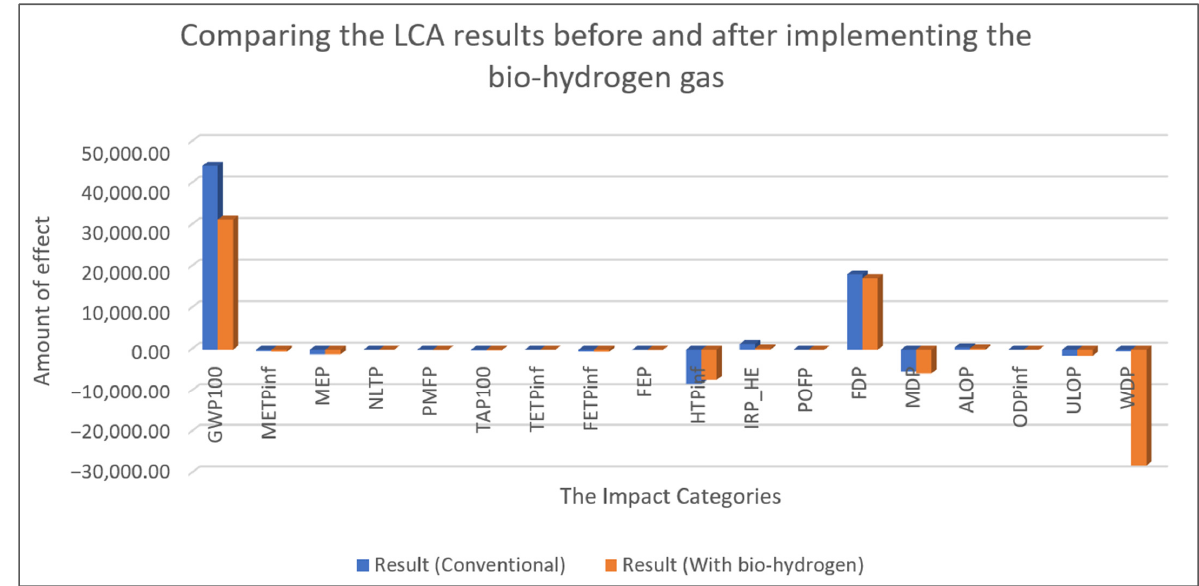
Figure 7. Comparing the impacts before and after the implementation of bio-hydrogen gas.